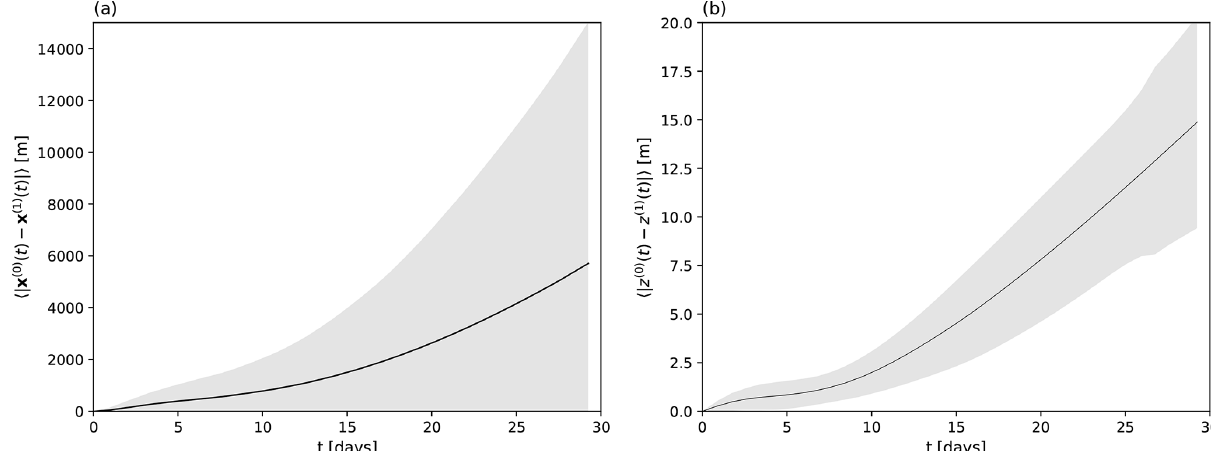
Figure 4. The distance, as a function of time, between trajectories obtained with constant nominal fluid density of ρ f = 1025kg/m 3 and the actual variable fluid density, both starting at the same initial location. The range of the values among all particles released in different points of the Mediterranean is indicated by the shaded area, while the solid line indicates the average over the particles. Particles have ρ p = 1041 . 5kg/m 3 , and all parameters are the same as for the summer release in Fig. 3. (a) Horizontal distances. (b) Vertical